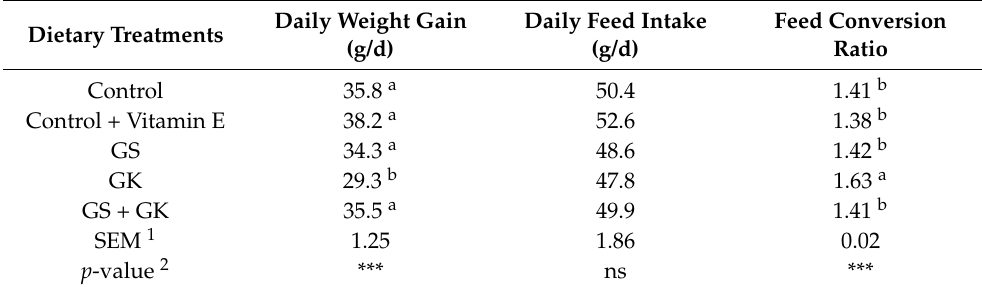
Table 4. Performance of broiler chickens (1 to 21 days) fed diets containing grape seed (GS) meal, grape skin (GK) meal or vitamin E. Daily Weight Gain Daily Feed Dietary Treatments (g/d)